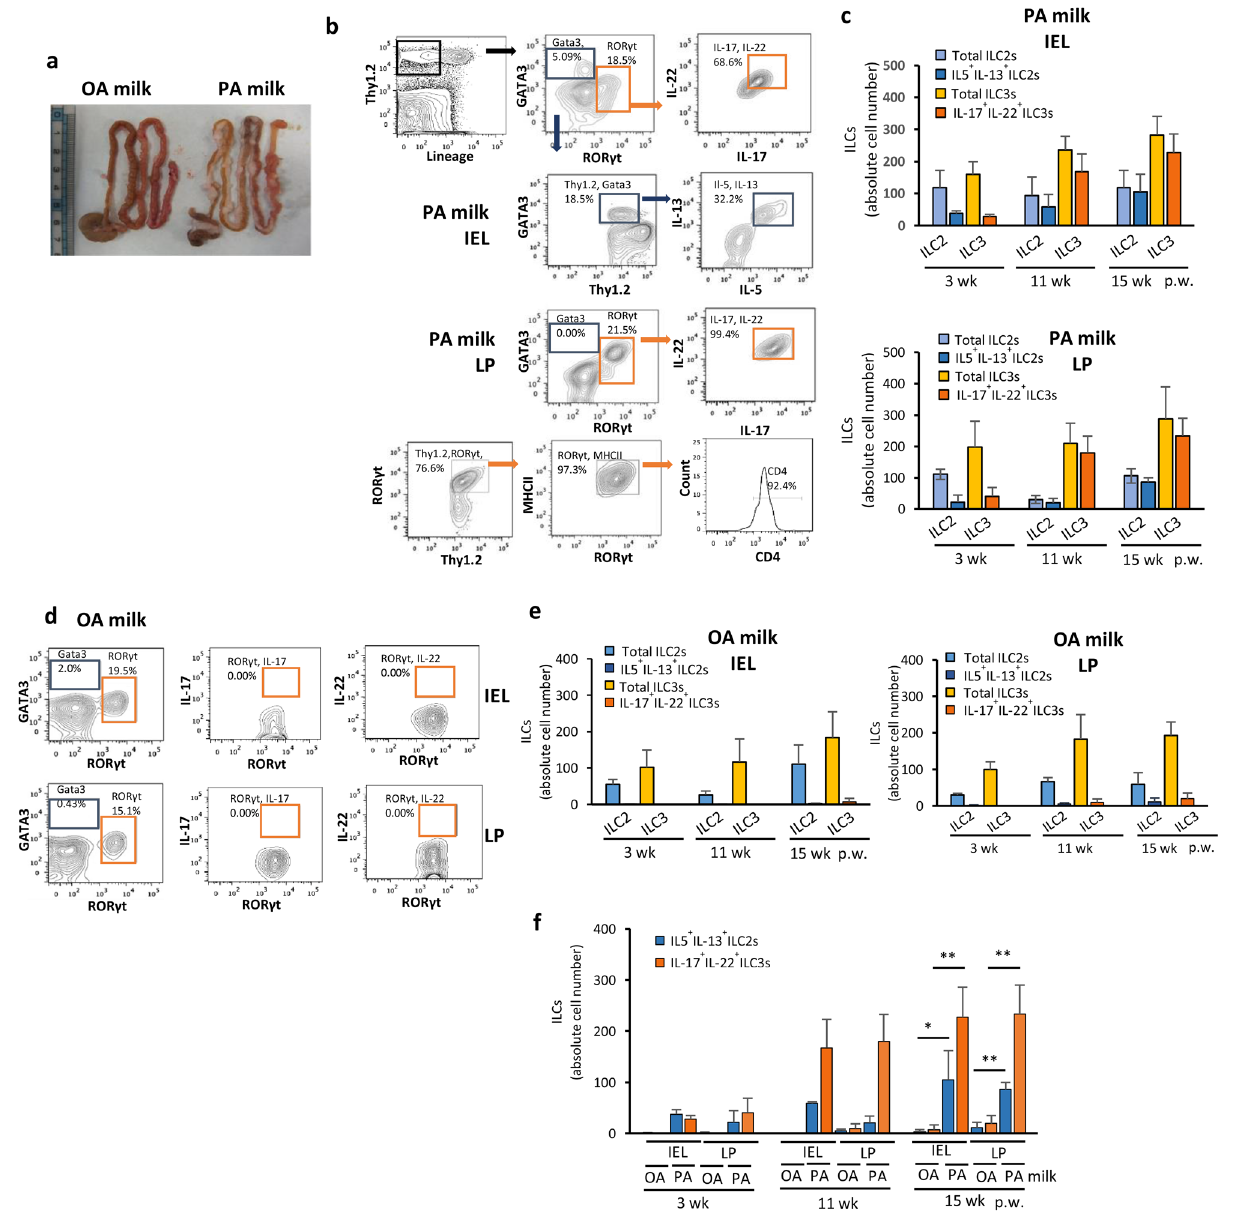
Figure 3. PA milk diet induced inflammatory ILCs in the small intestine. ( a ) Pictures of the entire intestines of PA milk and OA milk mice taken at 15 weeks post weaning (p.w.). ( b , d ) Representative FACS analysis of ( b ) PA milk and ( d ) OA milk mice at 15 weeks p.w. Small intestine intraepithelial layer (IEL) and lamina propria (LP) of mice at 3, 11 and 15 weeks p.w. were isolated via percol gradient centrifugation. Cells were stained with Thy1.2 and lineage markers (NK1.1, T cell receptor TCRβ and TCRγδ, CD11b, CD19, CD8, Gr-1 and Ter119). ILCs were gated by Lin − and Thy1.2 + expression, intracellularly stained for GATA3 (ILC2s) and RORγt (ILC3s), and interleukins (IL-5, IL-13, IL-17A and IL-22). ( c , e ) Absolute ILCs number and their respective interleukins in the IEL and LP at the indicated p.w. (n = 5 mice/group). ( f ) Comparison of the inflammatory ILCs in the IEL and LP of OA and PA milk. Results shown are representatives of at least three independent experiments. Normal diet group (ND) data is almost same as OA milk group results. Data are represented as mean ± SD. * P < 0.05, ** P < 0.01, one-way ANOVA. Data are analyzed with Prism8 (version 8.4.3, https:// www. graph pad. com/ scien tific- softw are/ prism), and FlowJo (version 10.7.1, https:// www. flowjo. com/ solut ions/ flowjo/ downl